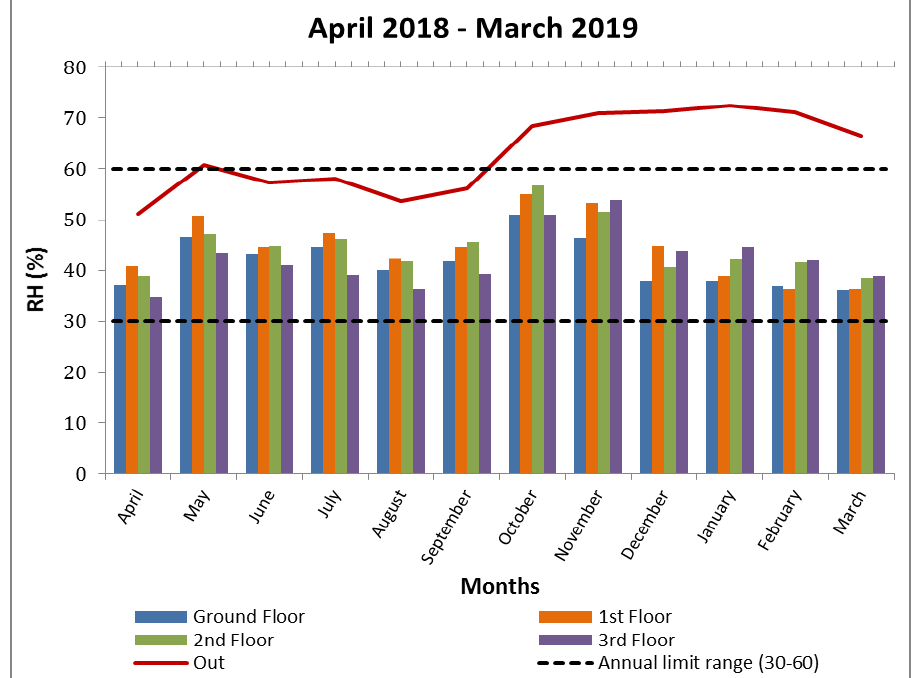
Figure 4. Monthly average RH (%) levels within the B FEPA building along with the respective limits.